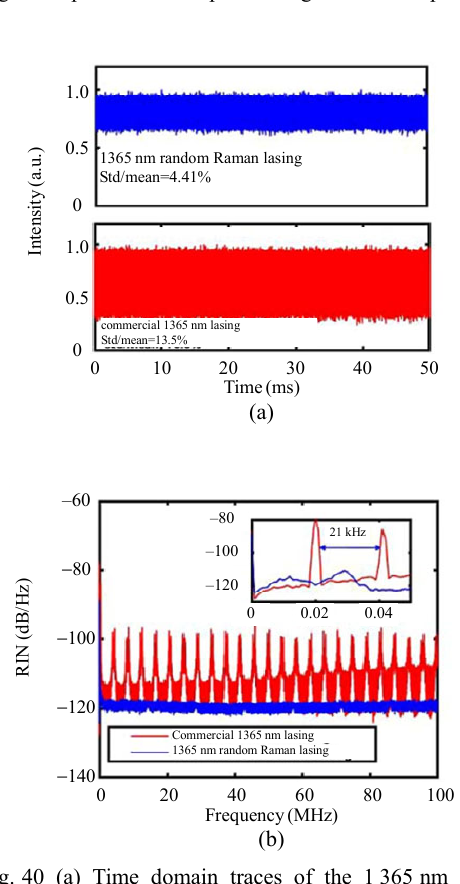
Fig. 40 (a) Time domain traces of the 1 365 nm random Raman lasing and the commercial 1 365 nm pump and (b) RIN of the 1 365 nm random Raman lasing and commercial 1 365 nm pump. Insert: enlarged view in 0 MHz – 0.05 MHz span. Blue line: 1 365 nm random Raman lasing; red line: commercial 1 365 nm lasing. Fig. 41 (a) Refractive index profile and (b) cross-section photograph of